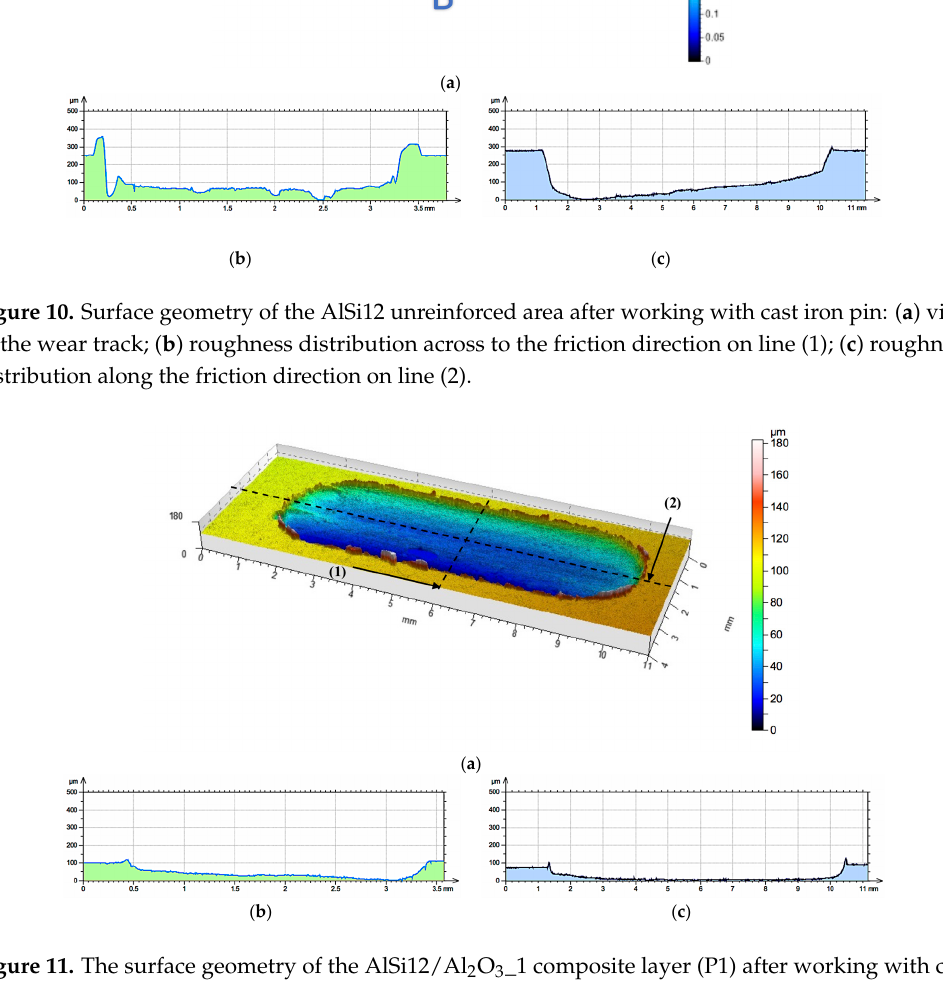
Figure 11. The surface geometry of the AlSi12/Al 2 O 3 _1 composite layer (P1) after working with cast iron pin: ( a ) view of wear track; ( b ) roughness distribution across to the friction direction on line (1); ( c ) roughness distribution along the friction direction on line (2).